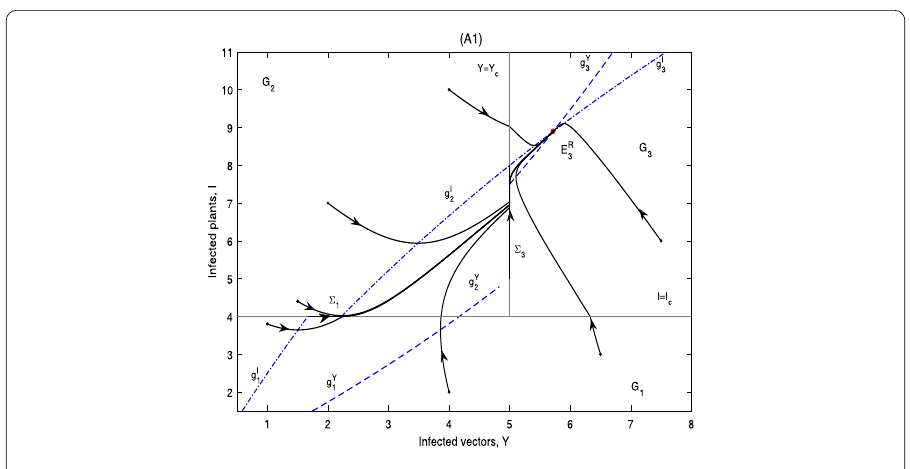
Figure 4 E R 3 is globally asymptotically stable in Case A.11 corresponding to different sliding modes Σ 3 . ( A1 ) Y c = 5, I c = 4. Σ 3 = { ( Y , I ) ∈ Ω 2 : g 1 < I < g 2 } . ( A2 ) Y c = 5, I c = 6. Σ 3 = { ( Y , I ) ∈ Ω 2 : I c < I < g 2 } . ( A3 ) Y c = 5, I c = 7.75. Σ 3 does not exist. (A2) and (A3) are omitted